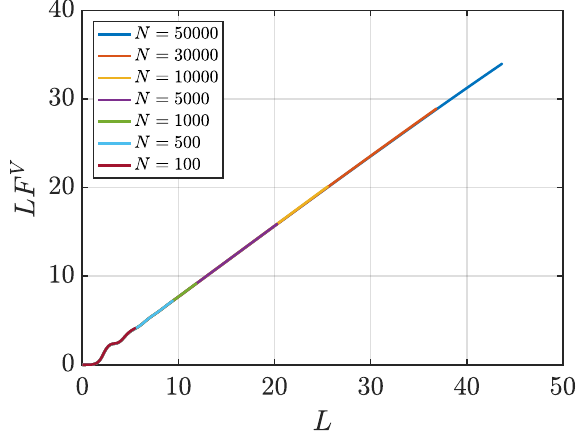
Figure 11. Surface effects of finite subvolumes multiplied by the diameter of the subvolume LF v (Equation (10)) vs. L for the WCA fluid at T = 2 and ρ = 0.6 (dimensionless units). The values of G v are computed for systems with varying number of molecules N . The used RDFs are provided in Figure 1.